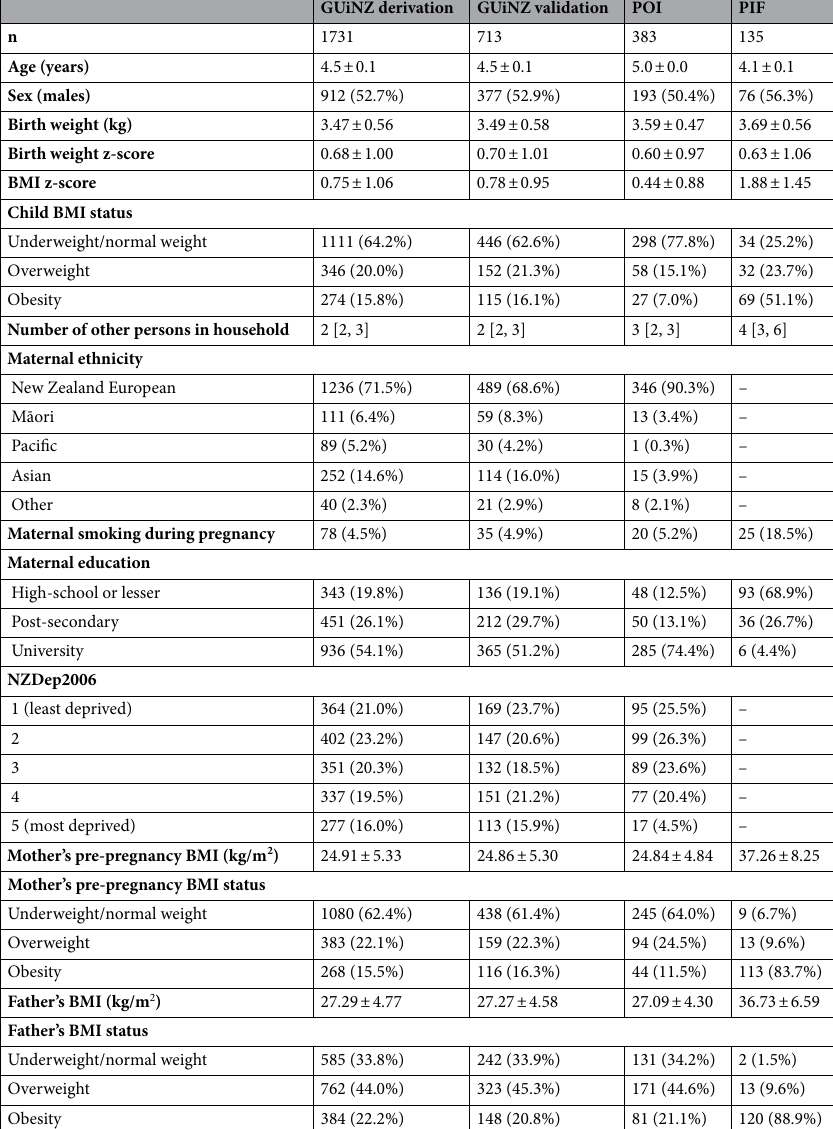
Table 1. Demographic information on the populations used for model derivation and validation. BMI body mass index, GUiNZ Growing Up in New Zealand Study, NZDep2006 New Zealand Index of [socioeconomic] Deprivation 2006, PIF Pacific Islands Families Study, POI Prevention of Overweight in Infancy Study. Where appropriate, data are n (%) or means ± standard deviations (SD), except for "Number of other persons